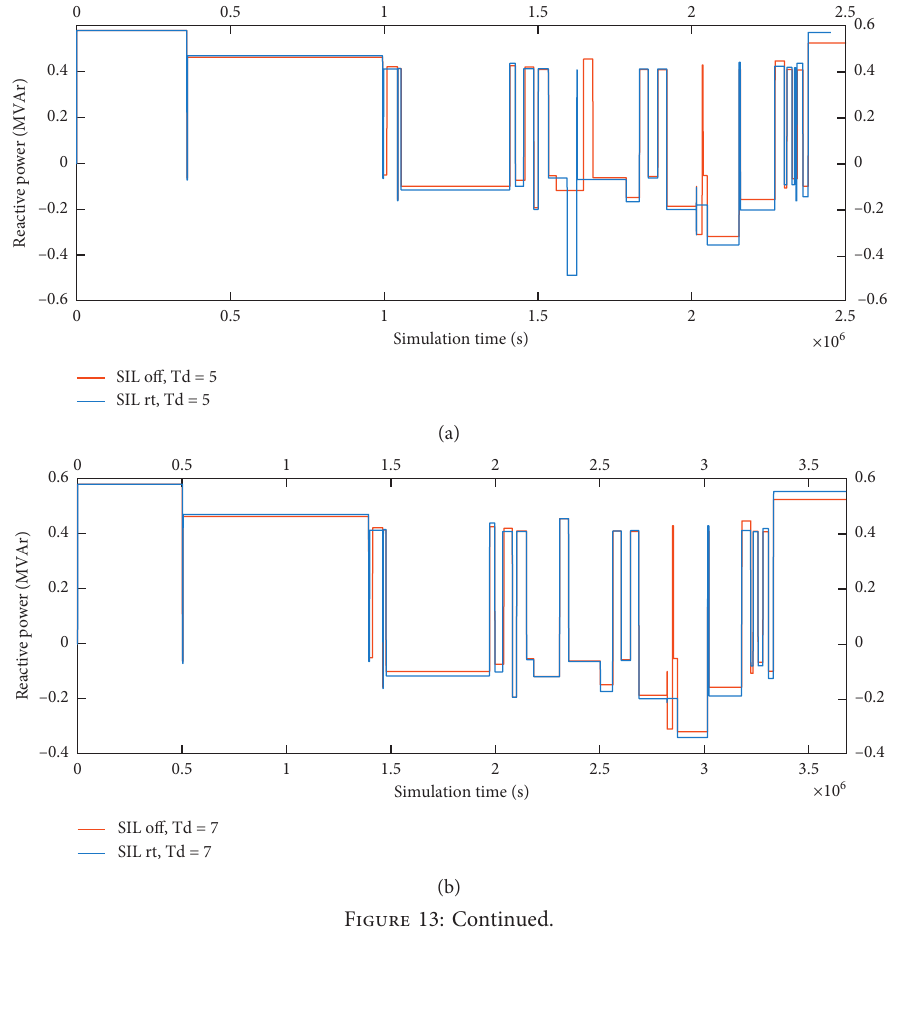
Figure 12: Results from the offline SIL and real-time SIL simulations. Reactive power flow of the WT converter when T RPW controller was set up to the TSO limits of ± 50 kVAr, except QD 1 � Q i + 200